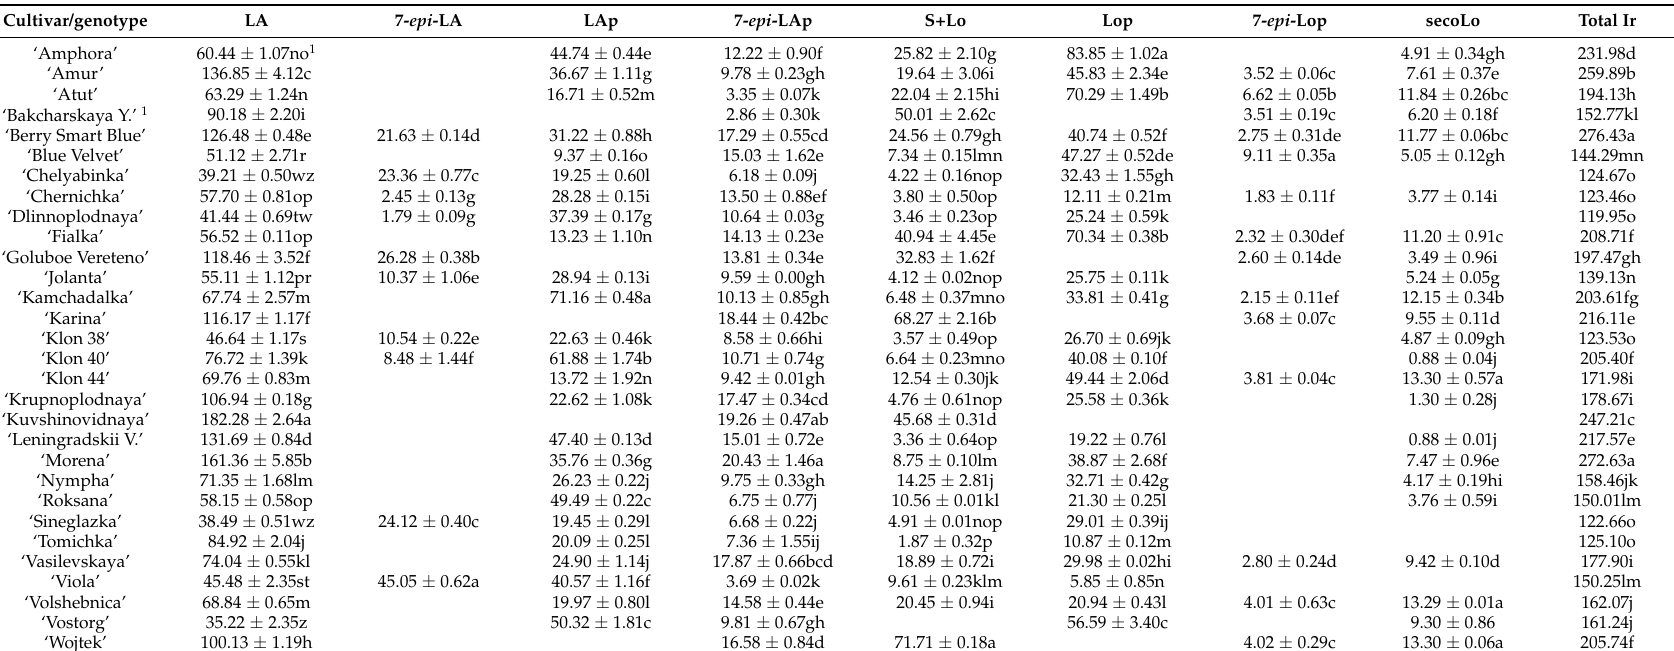
Table 2. Iridoid content (mg/100 g fw) of different blue honeysuckle cultivars and genotypes.